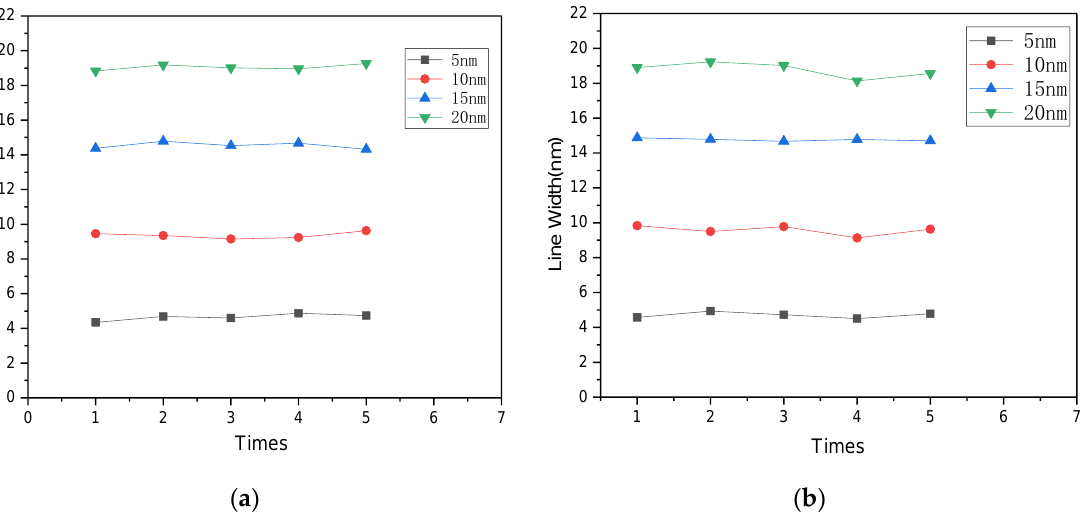
Figure 6. Traceable measurement results of middle CD value of multi-structured tip characterizer: ( a ) Left side; ( b ) Right side.